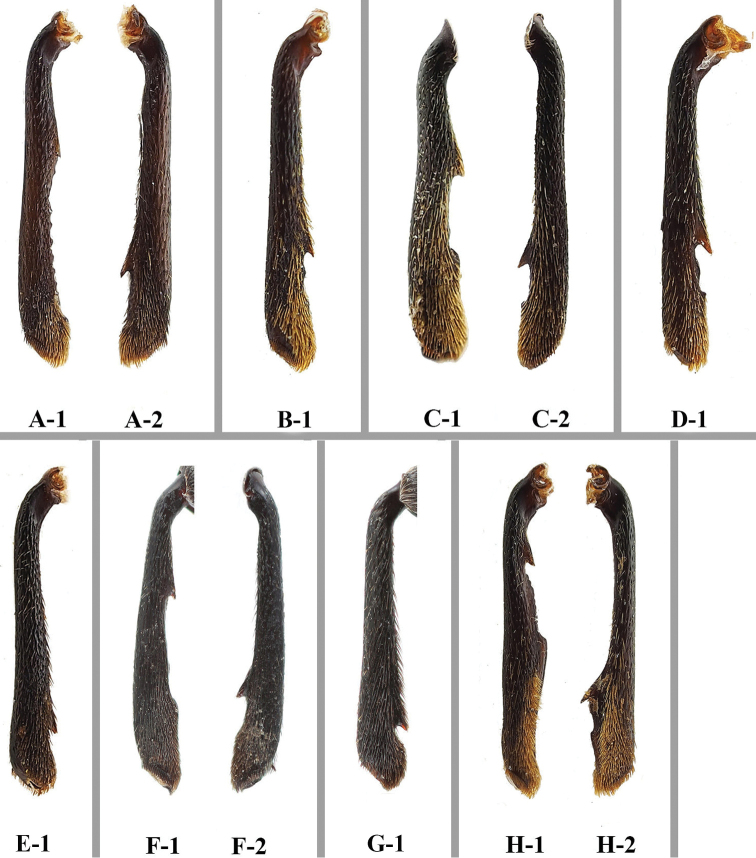
Male mesotibiae of Sinocymbachus spp AS.
angustefasciatusBS.
bimaculatusCS.
decorusDS.
excisipesES.
humerosusFS.
luteomaculatusGS.
parvimaculatusHS.
quadrimaculatus. 1 left 2 right.